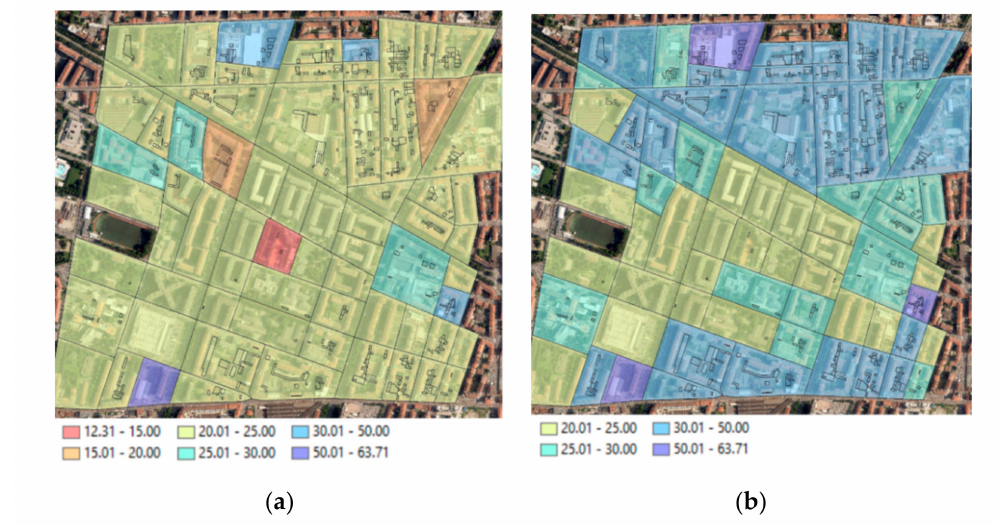
Figure 9. Solar Reflectance Index ( SRI ) (%) values of existing roof at block-of-building scale: ( a ) Before ( b ) and after high-reflectance